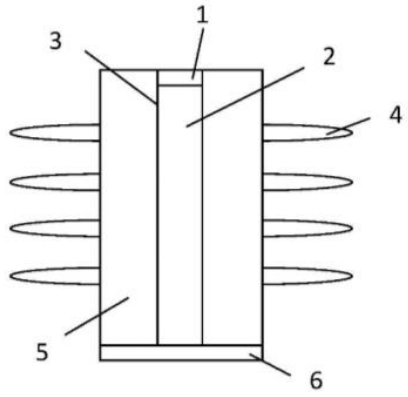
Figure 10. Schematic diagram of experimental sample structure.